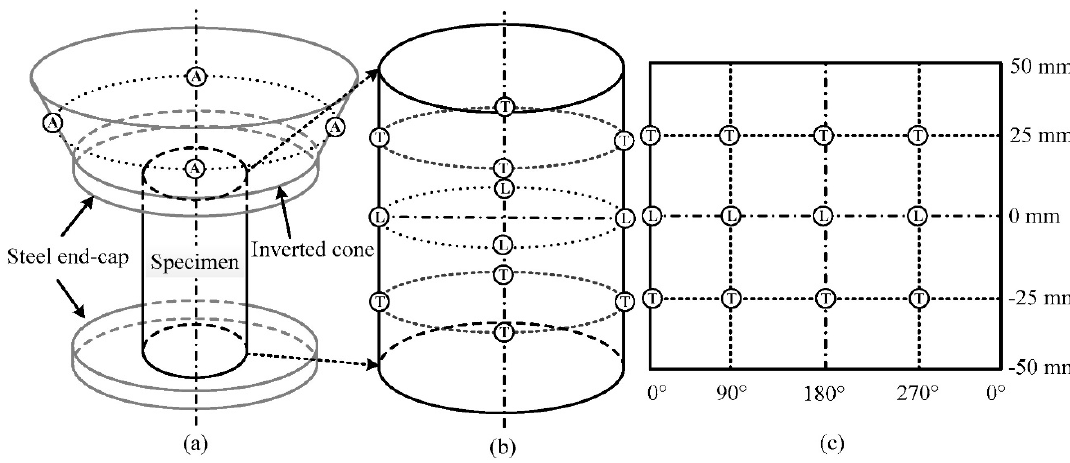
Figure 4. Samples equipped with eight acoustic emission (AE) transducers and eight strain extensometers. The symbols of A, L, and T denote the AE transducers, axial strain extensometers, and lateral strain extensometers, respectively. The dashed lines denote the locations of the different sensors, except the dash-dot line that denotes the center line. ( a ) Four axial strain extensometers in contact with the inclined surface of the inverted steel cone and two steel endcaps at the top and bottom of the sample; ( b ) overview location of the AE transducers and lateral strain extensometers on the specimen; and ( c ) the location of the AE transducers and lateral strain extensometers on the unfolded outside surface of the specimen.